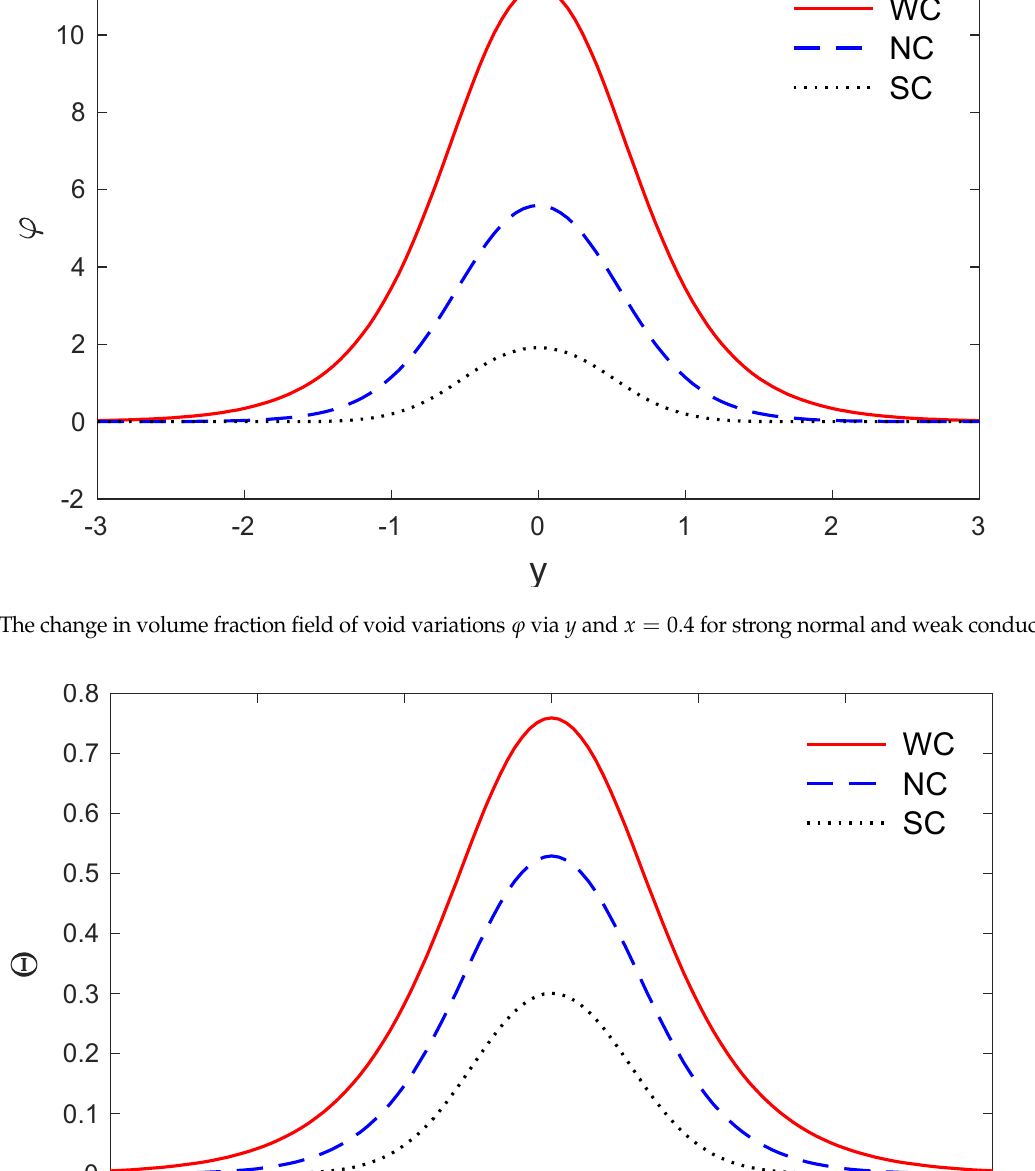
Figure 9. The variations of vertical displacement (cid:1874) via (cid:1877) with (cid:1876) = 0.4 for strong normal and weak conductivities.